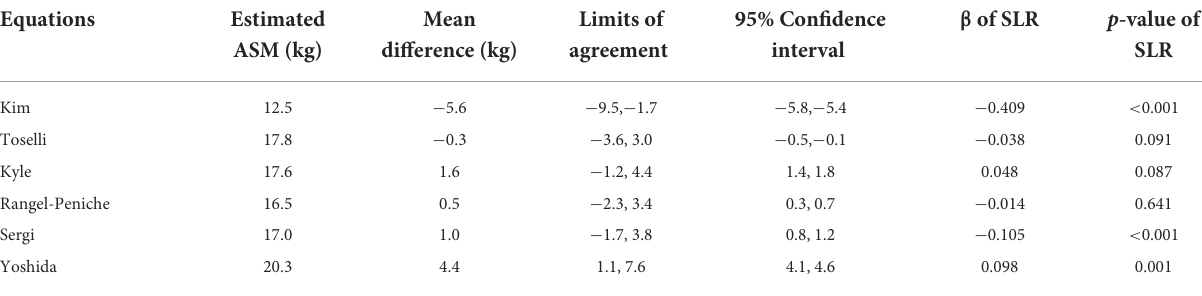
TABLE 3 Validation data of the six BIA equations.